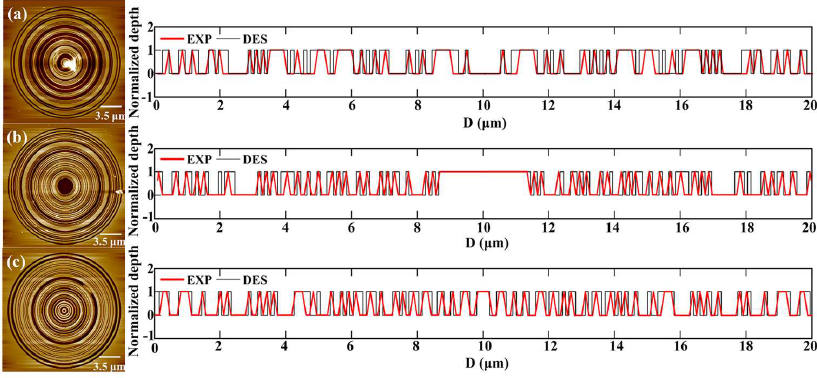
Figure 7. The fitted AFM cross-sectional diagram of the three SOLs with different focal lengths: ( a ) f = 4 μm, ( b ) f = 7 μm, ( c ) f = 10 μm.